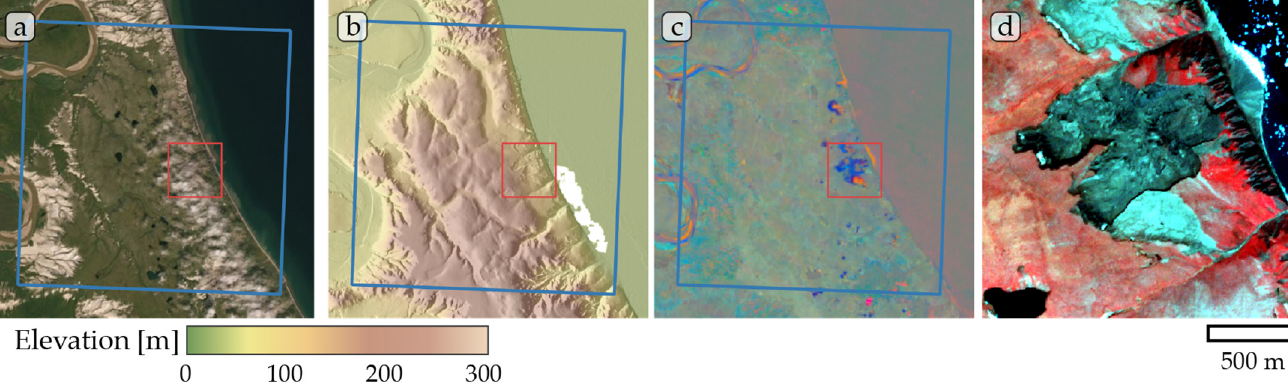
Figure A6. Study site Kolguev Island 01. ( a ) ESRI satellite layer, ( b ) ArcticDEM superimposed with hillshade, ( c ) Tasseled Cap trend visualization, ( d ) PlanetScope satellite image (NIR-R-G) acquired on 22 August 2019. Blue box, 10 × 10 km study site. Red box detailed view of ( d ). Note partially missing ArcticDEM data in ( b ). Figure A7. Study site Kolguev Island 02. ( a ) ESRI satellite layer, ( b ) ArcticDEM superimposed with hillshade, ( c ) Tasseled Cap trend visualization, ( d ) PlanetScope satellite image (NIR-R-G) acquired on 19 August 2019. Blue box, 10 × 10 km study site. Red box detailed view of ( d ). Note partially missing ArcticDEM data in ( b ).